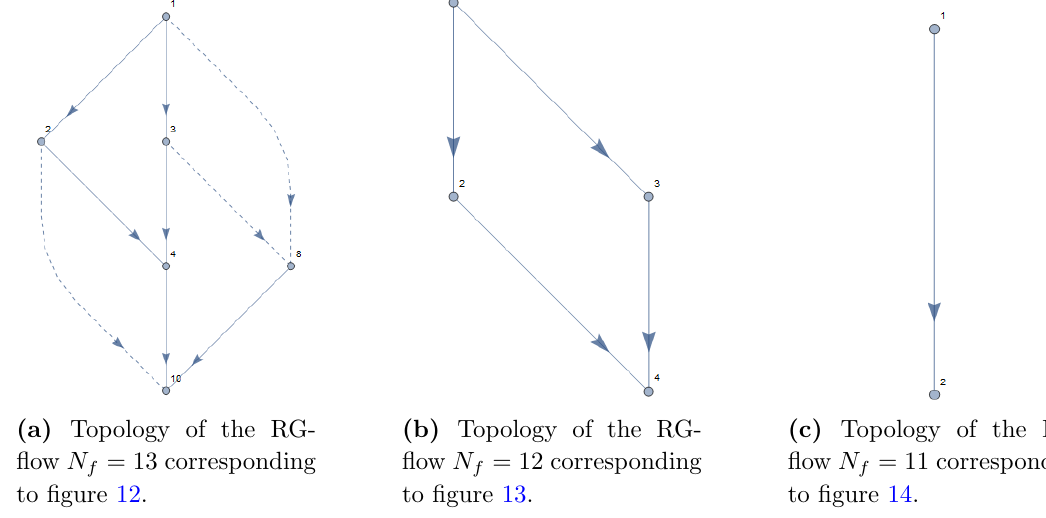
Figure 15. Graphical representation of the (cid:12)xed points and the skeleton of the invariant set on the (cid:11) g = (cid:11) nt subspace at N c = 3 and various values of N f . g